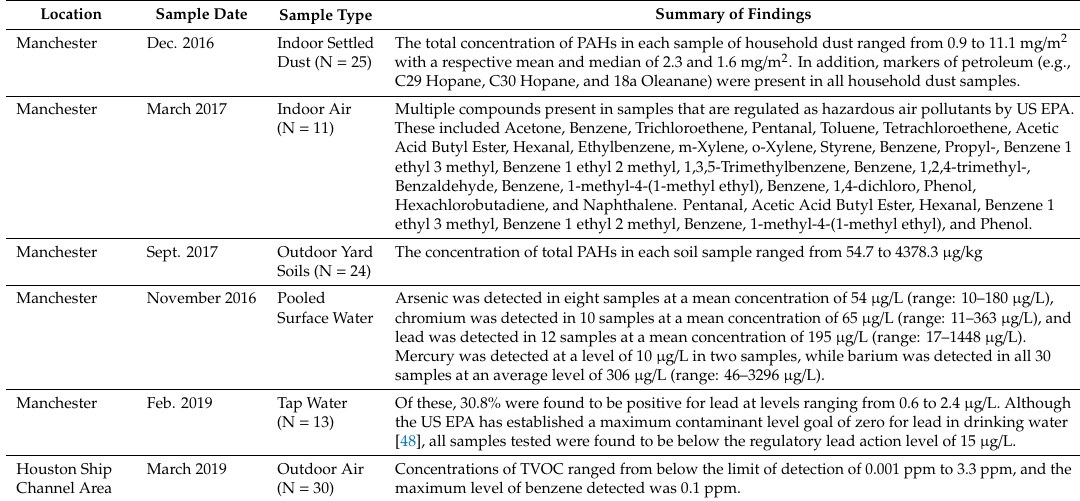
Table 1. Overview of environmental sampling in Houston Ship Channel neighborhoods,